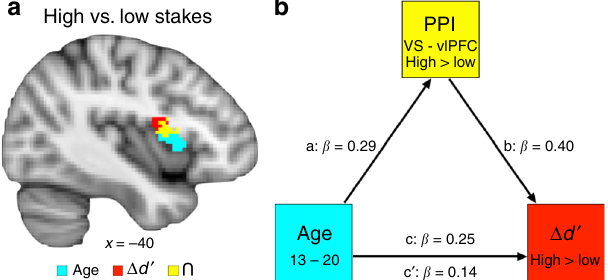
Fig. 5 Stakes-selective functional connectivity. a Conjunction for high stakes versus low stakes targets PPI analysis with ventral striatum seed. PPI analyses were seeded in the ventral striatum to identify connectivity that was enhanced for high stakes relative to low stakes targets, and covariates were included for age (blue) and d ′ high – low (red); (small volume corrected t tests, FWE p < 0.05). A conjunction analysis identi fi ed regions of overlap (yellow). b Ventral striatum – vlPFC connectivity mediation model. VS – vlPFC connectivity for high stakes versus low stakes targets mediated the relationship between age and improved performance for high versus included as a predictor in the PPI analysis for high stakes versus low stakes targets with the VS seed. For the left and right VS seeds, d ′ high – low was associated with enhanced coupling for high stakes in bilateral vlPFC (Fig. 5a; SVC t test, FWE p < 0.05, left seed: 222 voxels at x = − 44, y = 8, z = − 2; 319 voxels at x = 36, y = 12, z = 4; right seed: 291 voxels at x = − 38, y = 4, z = 14; 422